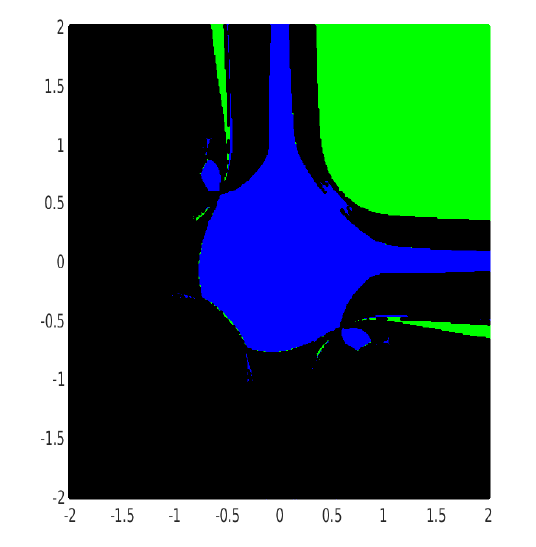
Figure 1. Dynamical plane of the methods (2) with basins of attraction for the Example